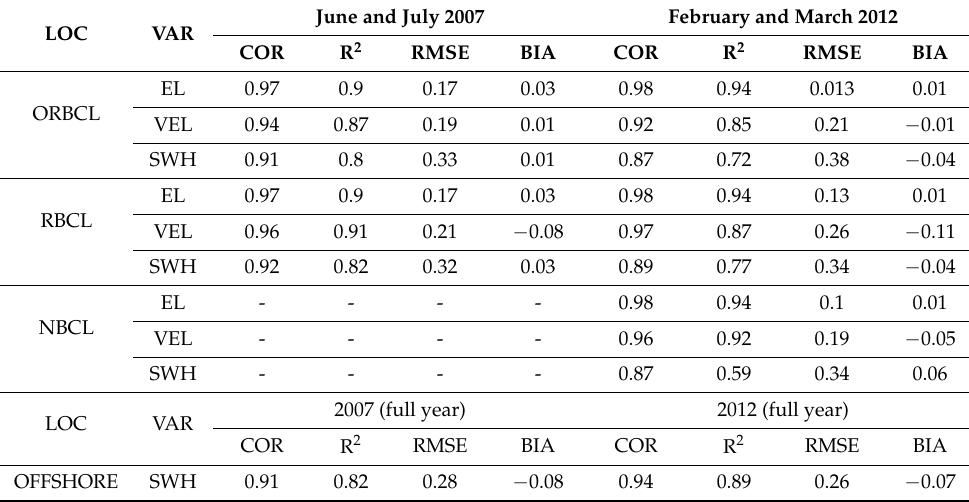
Table 4. A statistical summary for model calibration and